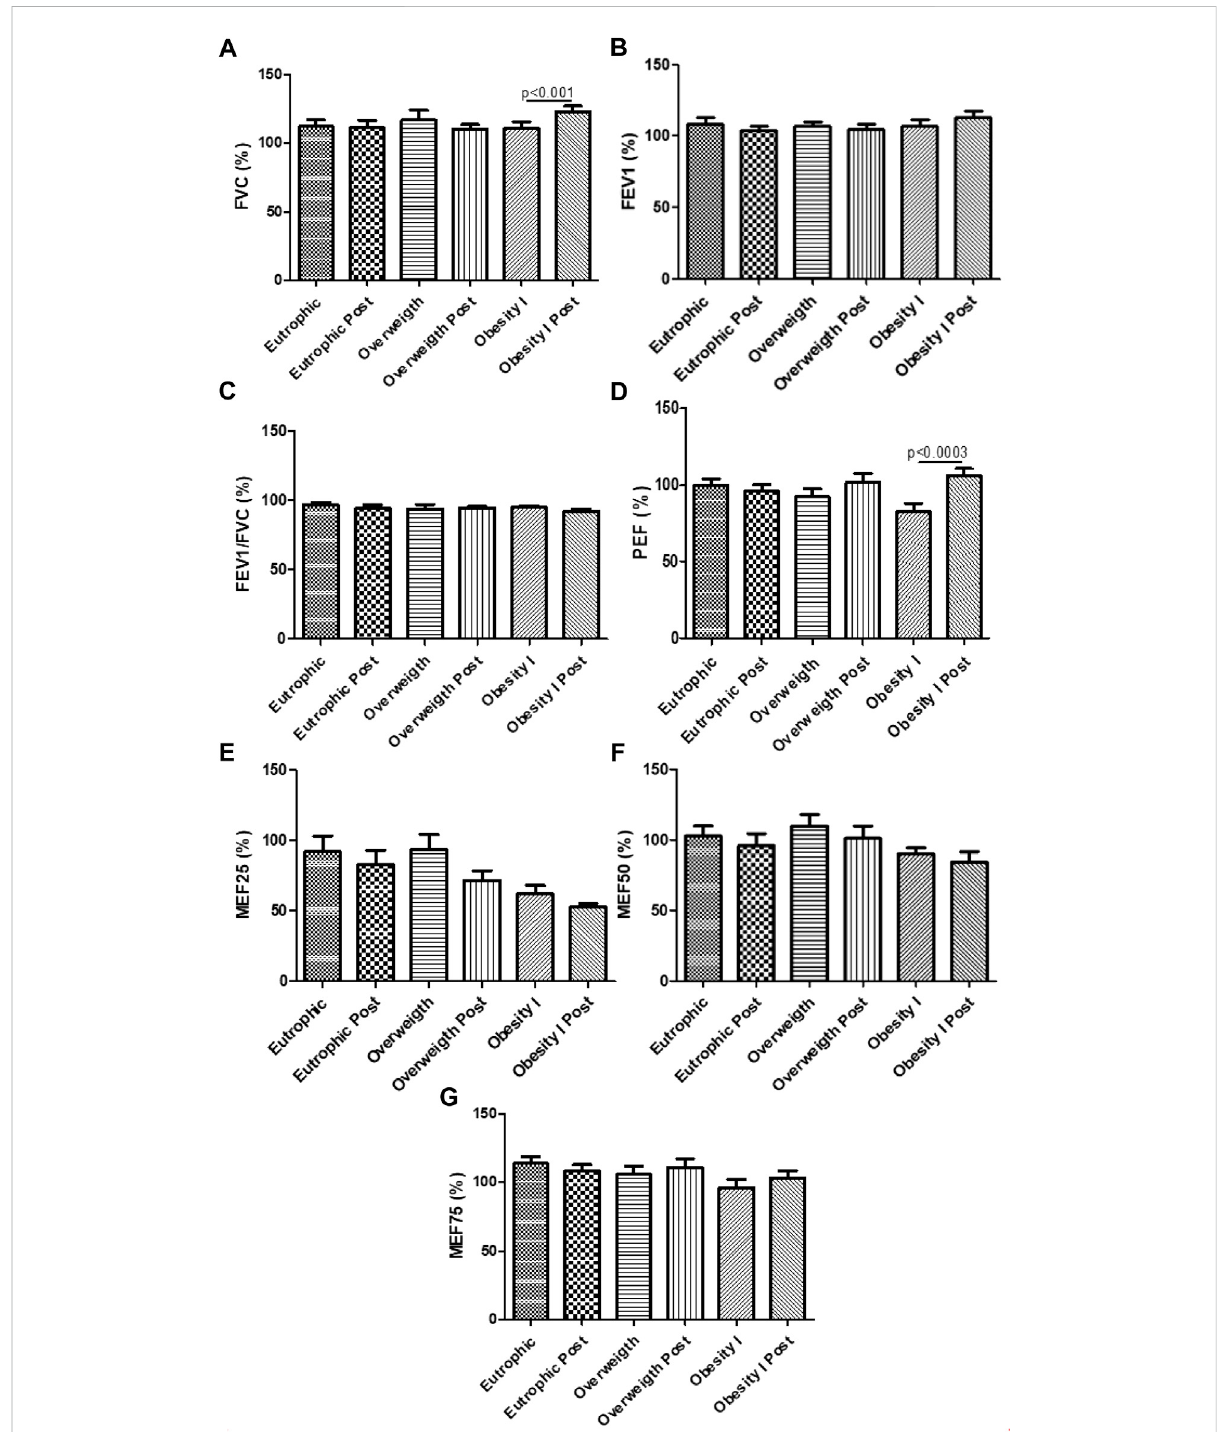
FIGURE 3 Effects of combined training on the lung function test. Figure 3A shows the FVC%; Figure 3B the VEF1%; Figure 3C the VEF1/FVC; Figure 3D PEF%; Figure 3E MEF25%; Figure 3F MEF50%; Figure 3G MEF75%. Paired t -test was performed to compare the pre- and post-effects of rehabilitation (i.e., eutrophic non-obese pre x eutrophic non-obese post; overweight pre x overweight post; obesity I pre x obesity I post). A p < 0.05 was considered statistically signi fi cant. These data presented parametric distribution and were additionally evaluated using one way ANOVA followed by the Newman – Keuls test for multiple comparisons among the